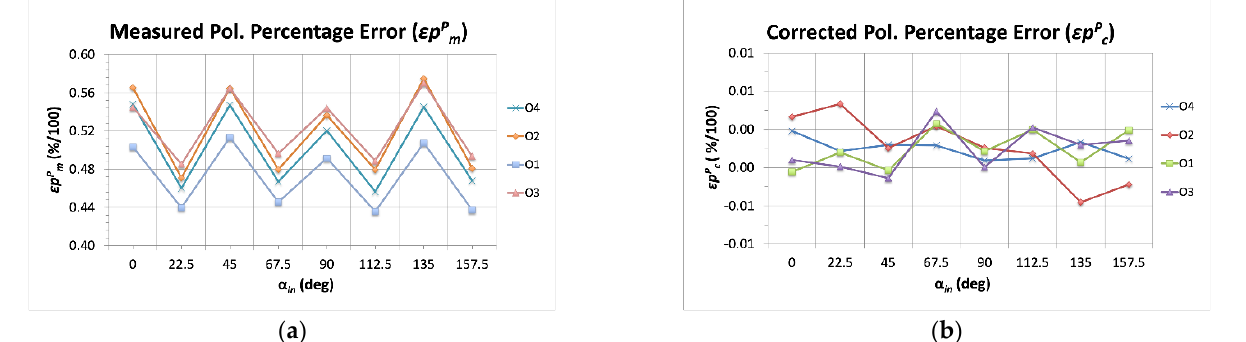
Figure 5. Measured polarization percentage correction factors ( fp Pm , blue crosses) superposed to the fitted ones ( fp Pf , black traces) with five multiplicative terms, given as a function of the measured polar- ization angles ( α m ) and for each one of the polarimeter outputs: O 1 ( a ), O 2 ( b ), O 3 ( c ), and O 4 ( d ).